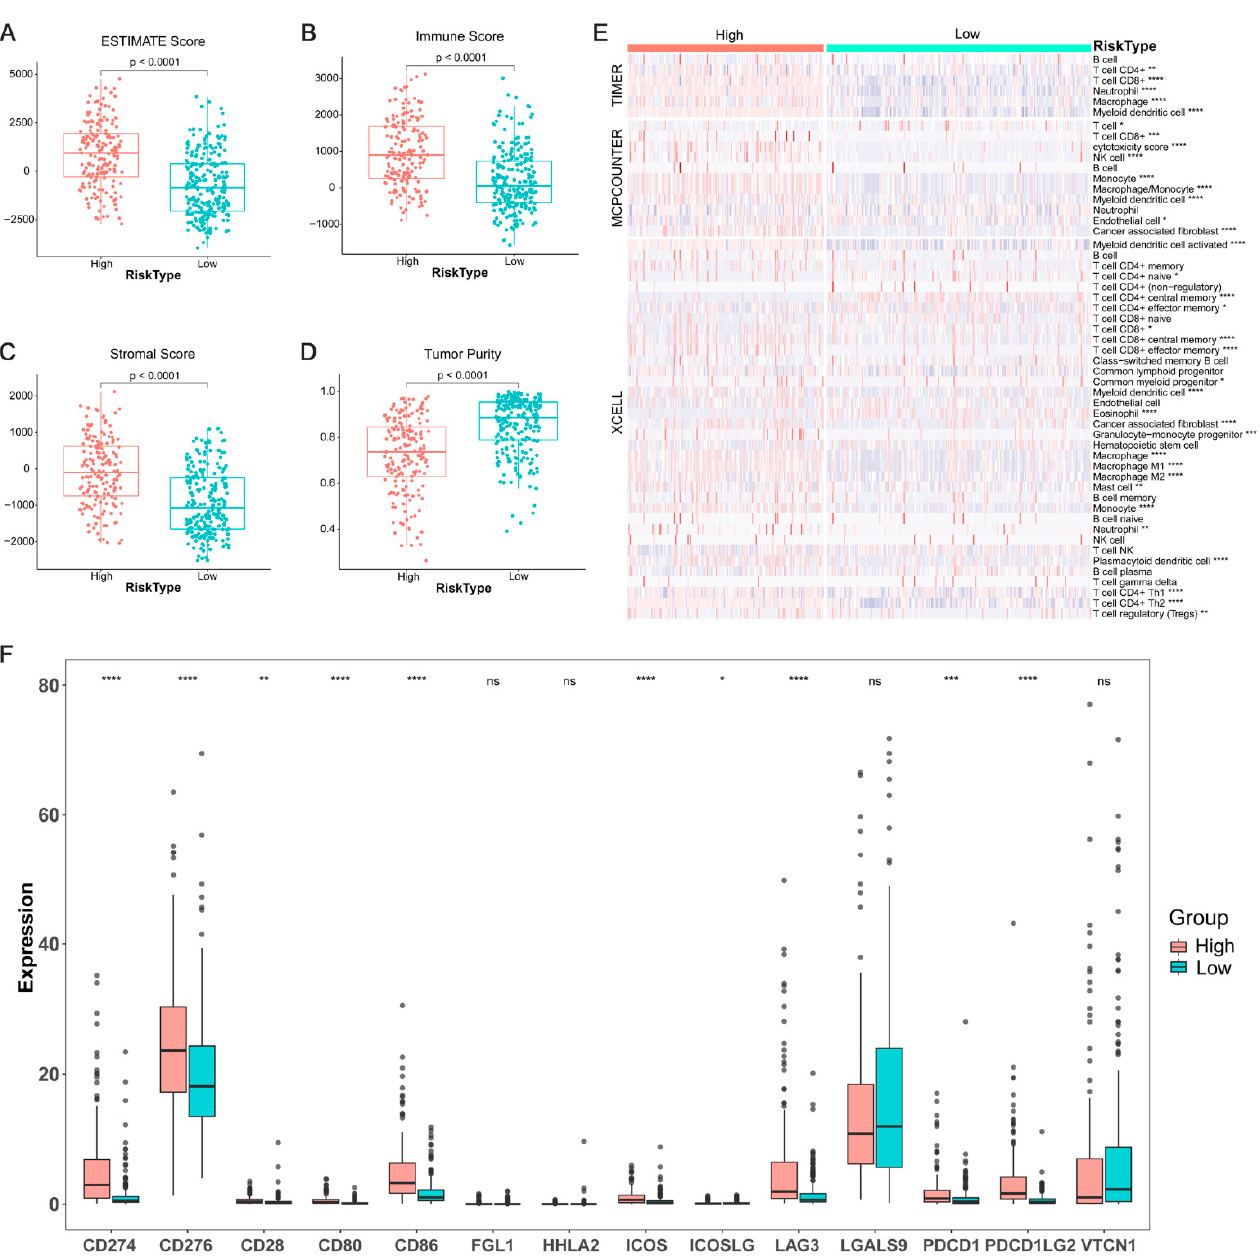
Figure 9. Tumor immune infiltrating and the expression of immune check gene between the high/low-risk groups. Tumor immune infiltrating level between the high/low-risk groups ( A – D ); proportions of tumor-infiltrating cells between the high/low-risk groups ( E ); different expression levels of immune check genes between the high/low-risk groups ( F ). Where *, p < 0.05, **, p < 0.01, ***, p < 0.001 and ****, p < 0.0001., ns not significant.